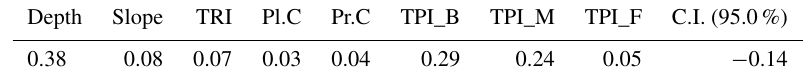
Table B7. The Spearman’s rank correlation coefficient between Mn nodules m − 2 , depth, and bathymetric